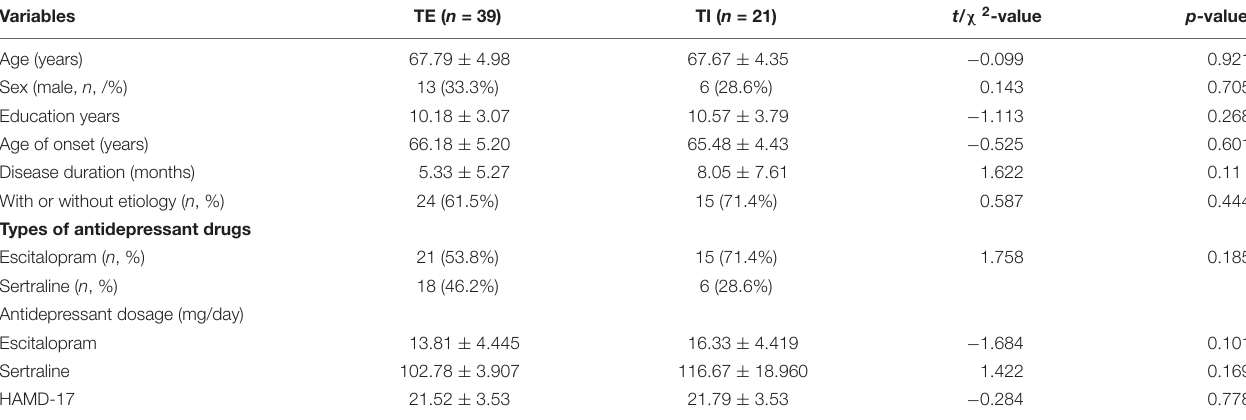
TABLE 3 | The demographic and clinical characteristics of the TE and TI group.